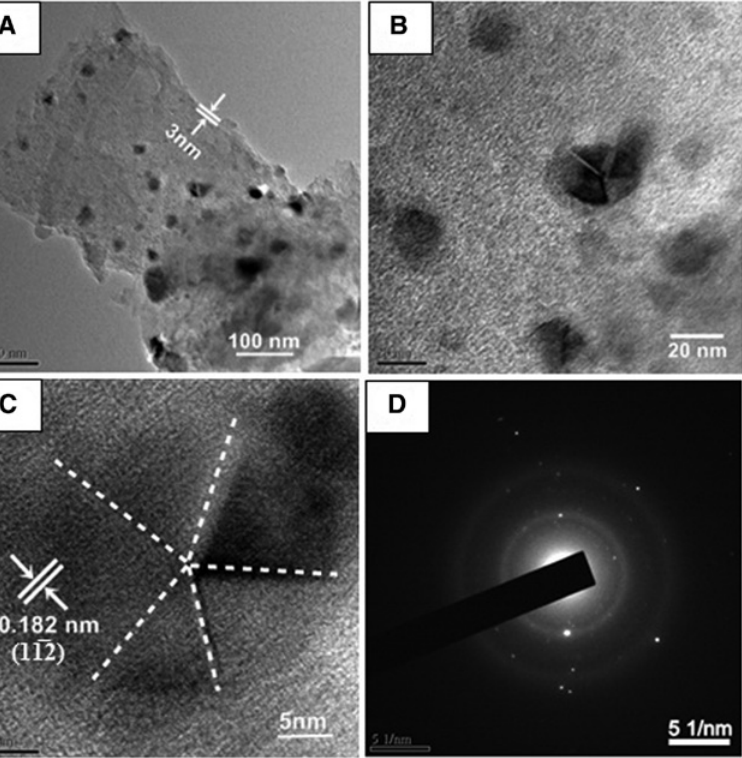
Figure 2: Electron microscopy of nanocomposite. (A, B) transmission electron microscopy (TEM) image, (C) high resolution transmission electron microscopy (HRTEM) image and (D) electron diffraction